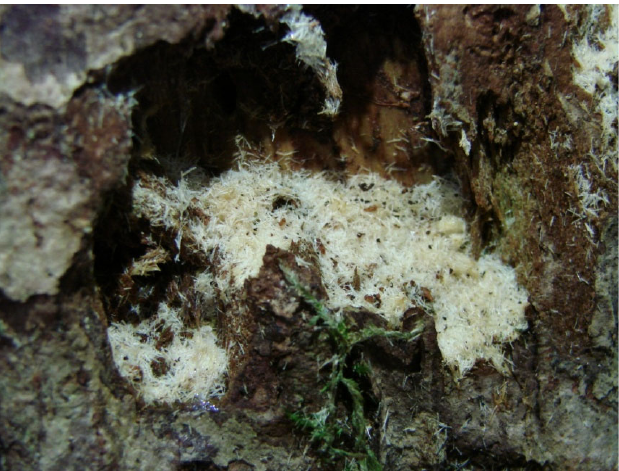
Figure 6. Filiform sawdust on the bark of silver fir tree–the symptom of T. oxyurus infestation. Drilling and biting the corridors took place, like the oak pinhole borer Platypus cylindrus (Fabricius, 1792), where the female leads the drilling. With her strong mandibles, the female bit off pieces of wood, and slowly entered the interior of the trunk. The female was followed by a male who threw bites of sawdust out of the trunk. Each gallery system had a one- entrance opening. Entry of T. oxyurus into the silver fir wood consisted of the main parent corridor, which extended from the entrance on the bark towards the centre of the trunk. With the entry of these insects into the fir wood, infection of the wood itself with fungal spores occurred. During the brooding, the female laid eggs. After some time, pale yellow, shiny larvae emerged from the eggs, which, like the adults, fed on the mycelium of the fungus. The larvae also had well-developed mandibles on their heads, with which they gnawed their corridors. By the following spring, parental adults, eggs and larvae could be found in the gallery systems (Figure 7), which could mean that the female laid eggs until that spring. From spring to June, parental adults and larvae of all developmental stages could be found in the galleries (Figure 8). After the larvae had sufficiently developed and reached the last larval stage, in the lateral corridors that approximately followed the growth ring line, they began to gnaw short corridors perpendicular to the previous ones and parallel to the longitudinal axis of the trunk. Before pupation, they turned their heads towards the exit, which they closed with grits, and thus made a pupating cradle. T. oxyurus has a pupa libera. Pupation began in early July, and in mid-July the first adults of the new generation appeared. At that point, all developmental stages were present except the eggs: parental adults were dark brown, larvae before pupation, pupae and young adults were light brown. A new generation emerged from the fir wood in search of a mate and a suitable host to produce their offspring (Table 1). During the observation of the T. oxyurus life cycle, it was observed that adult individuals of this species possess the property of an elytro-tergal type of stridulation. Stridulation is the ability to produce sound or vote by rubbing one part of the body against another. This property helps individuals to find their partners, communicate with each other, and produce sound if they are in